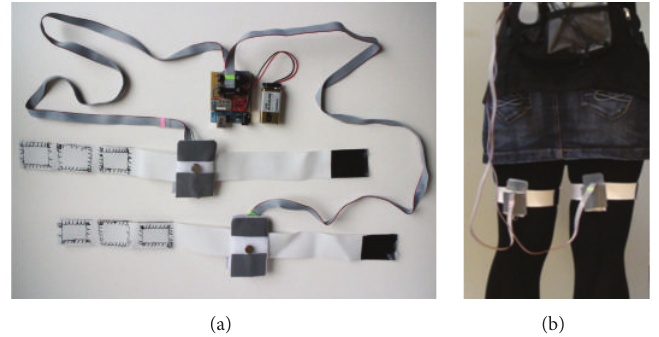
Figure 5: (a) Wearable parts of the exercise device and (b) their attachment